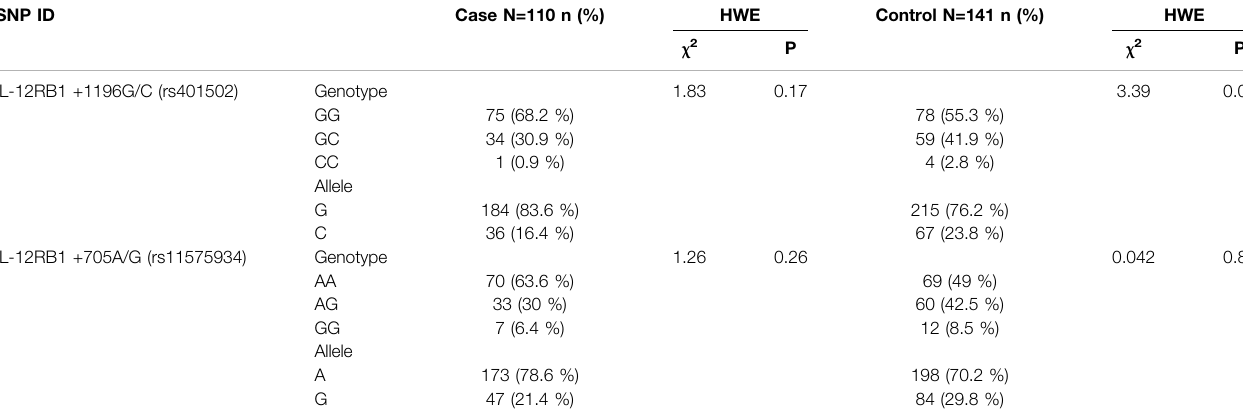
TABLE 2 | Hardy – Weinberg test for allelic and genotypic frequencies in patients with CRC and the control group. SNP ID